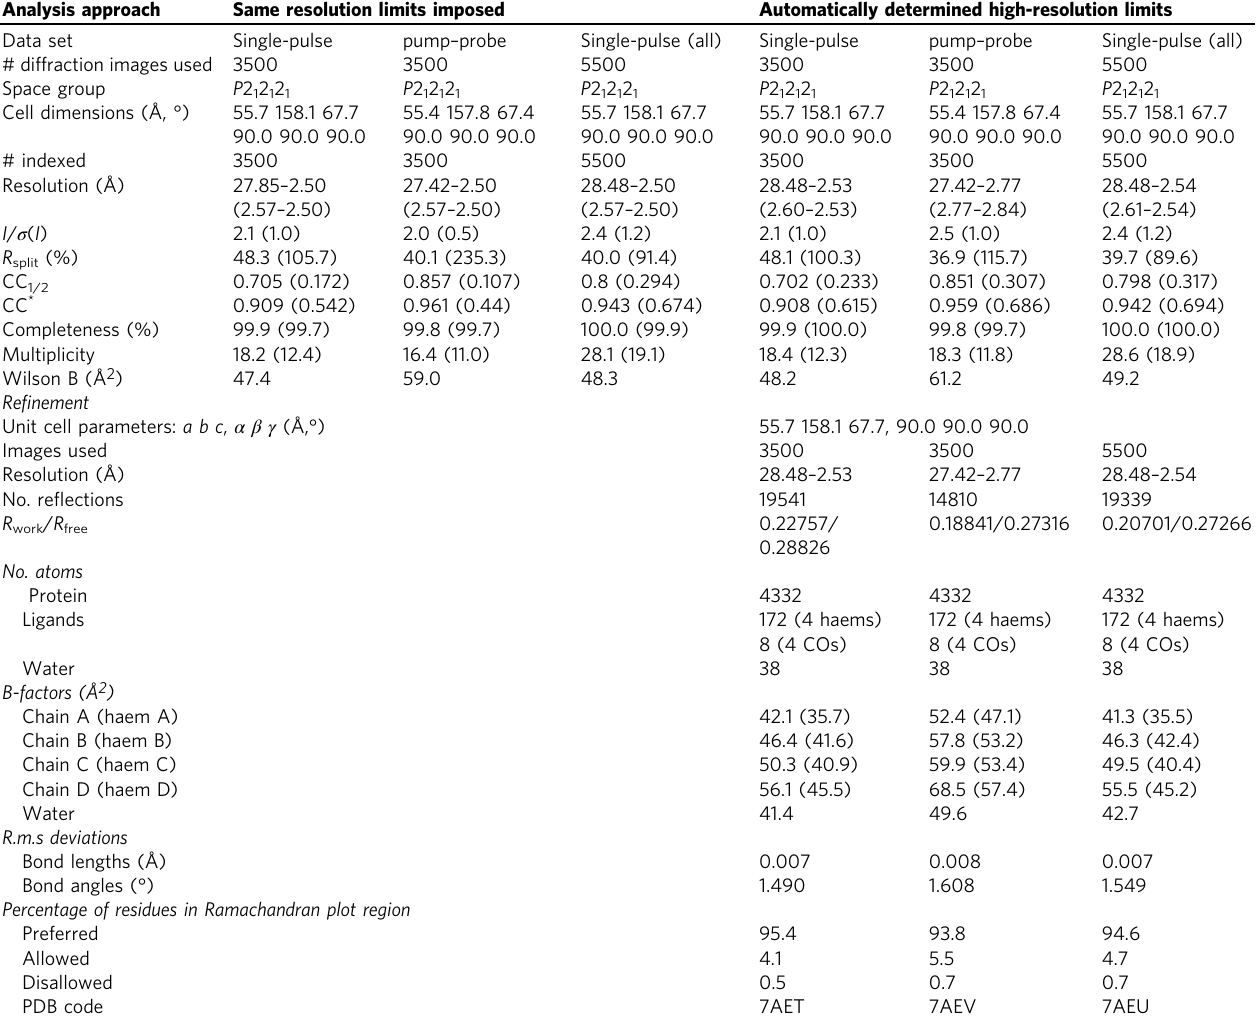
Table 1 Data and re fi nement statistics calculated for probe-only and pump – probe